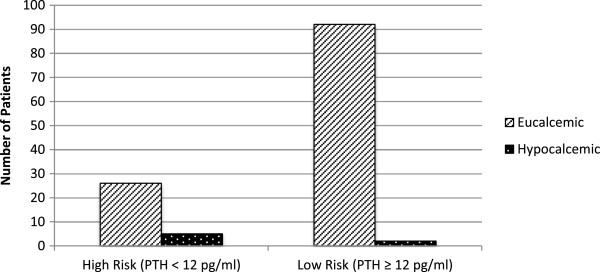
Proportion of patients in high and low risk groups developing hypocalcemia:Patients who developed hypocalcemia in the high risk group (5/31) were identified as being likely to develop hypocalcemia, but failed to adequately respond to the initial oral prophylactic calcium and vitamin D supplementation. Patients who developed hypocalcemia in the low risk group are those who were inaccurately categorized by our PTH cut-off (2/94). All the patients who developed hypocalcemia had only mild symptoms. There were no serious sequelae in any patients.